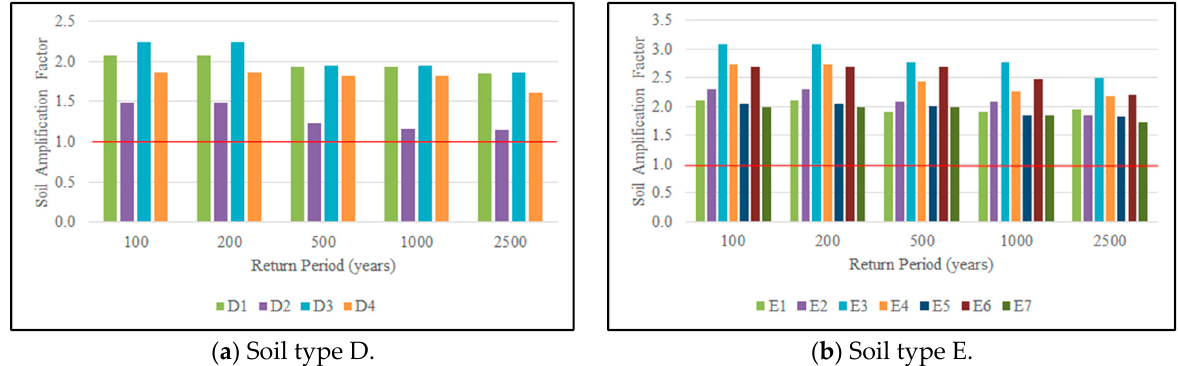
Figure 10. Soil amplification factor for soil types D and E under far-field seismic events.